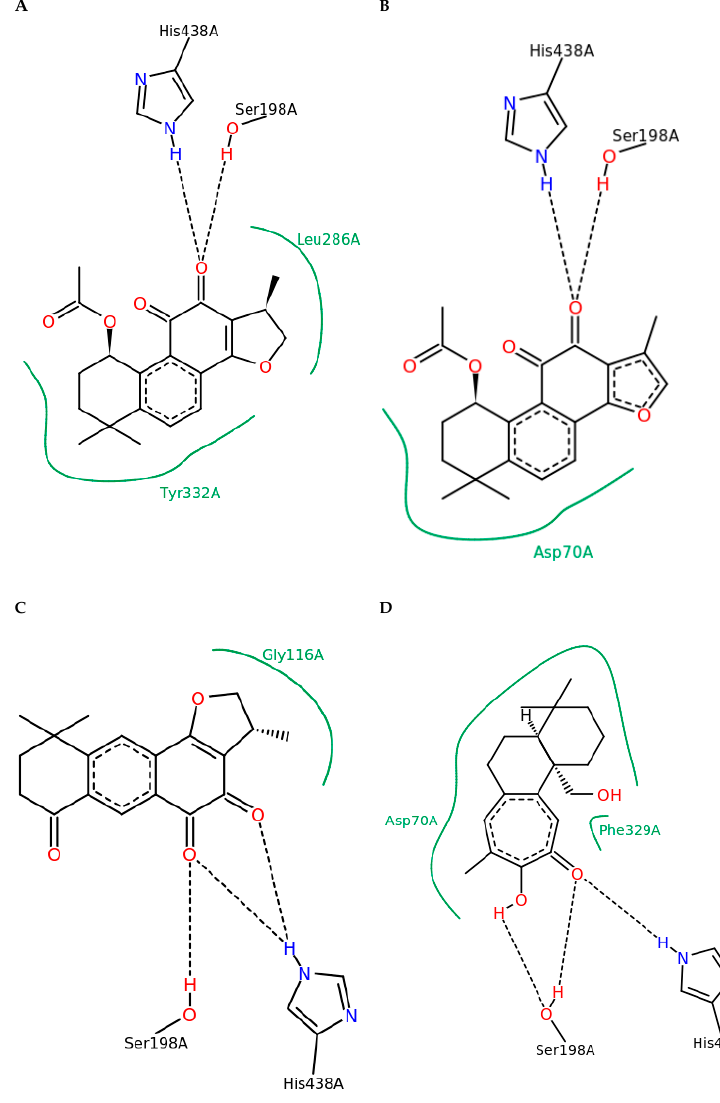
Figure 3. 2D depiction of main interactions established between compounds 1 – 4 and BChE. The green continuous line represents hydrophobic interactions while the black dashed lines correspond to hydrogen bonds. ( A ) 2D depiction of main interactions established between compound 1 and BChE. ( B ) 2D depiction of main interactions established between compound 2 and BChE. ( C ) 2D depiction of main interactions established between compound 3 and BChE. ( D ) 2D depiction of main interactions established between compound 4 and